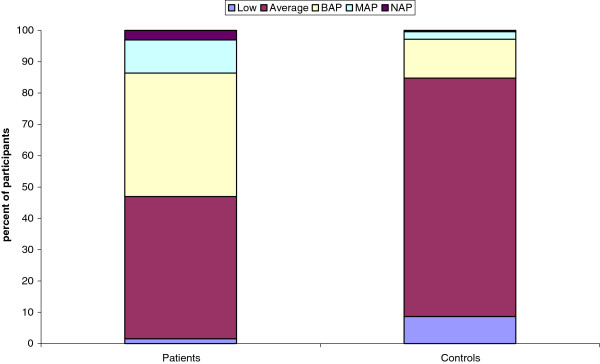
Percentage of participants with each Autism Spectrum Quotient (AQ) phenotype.